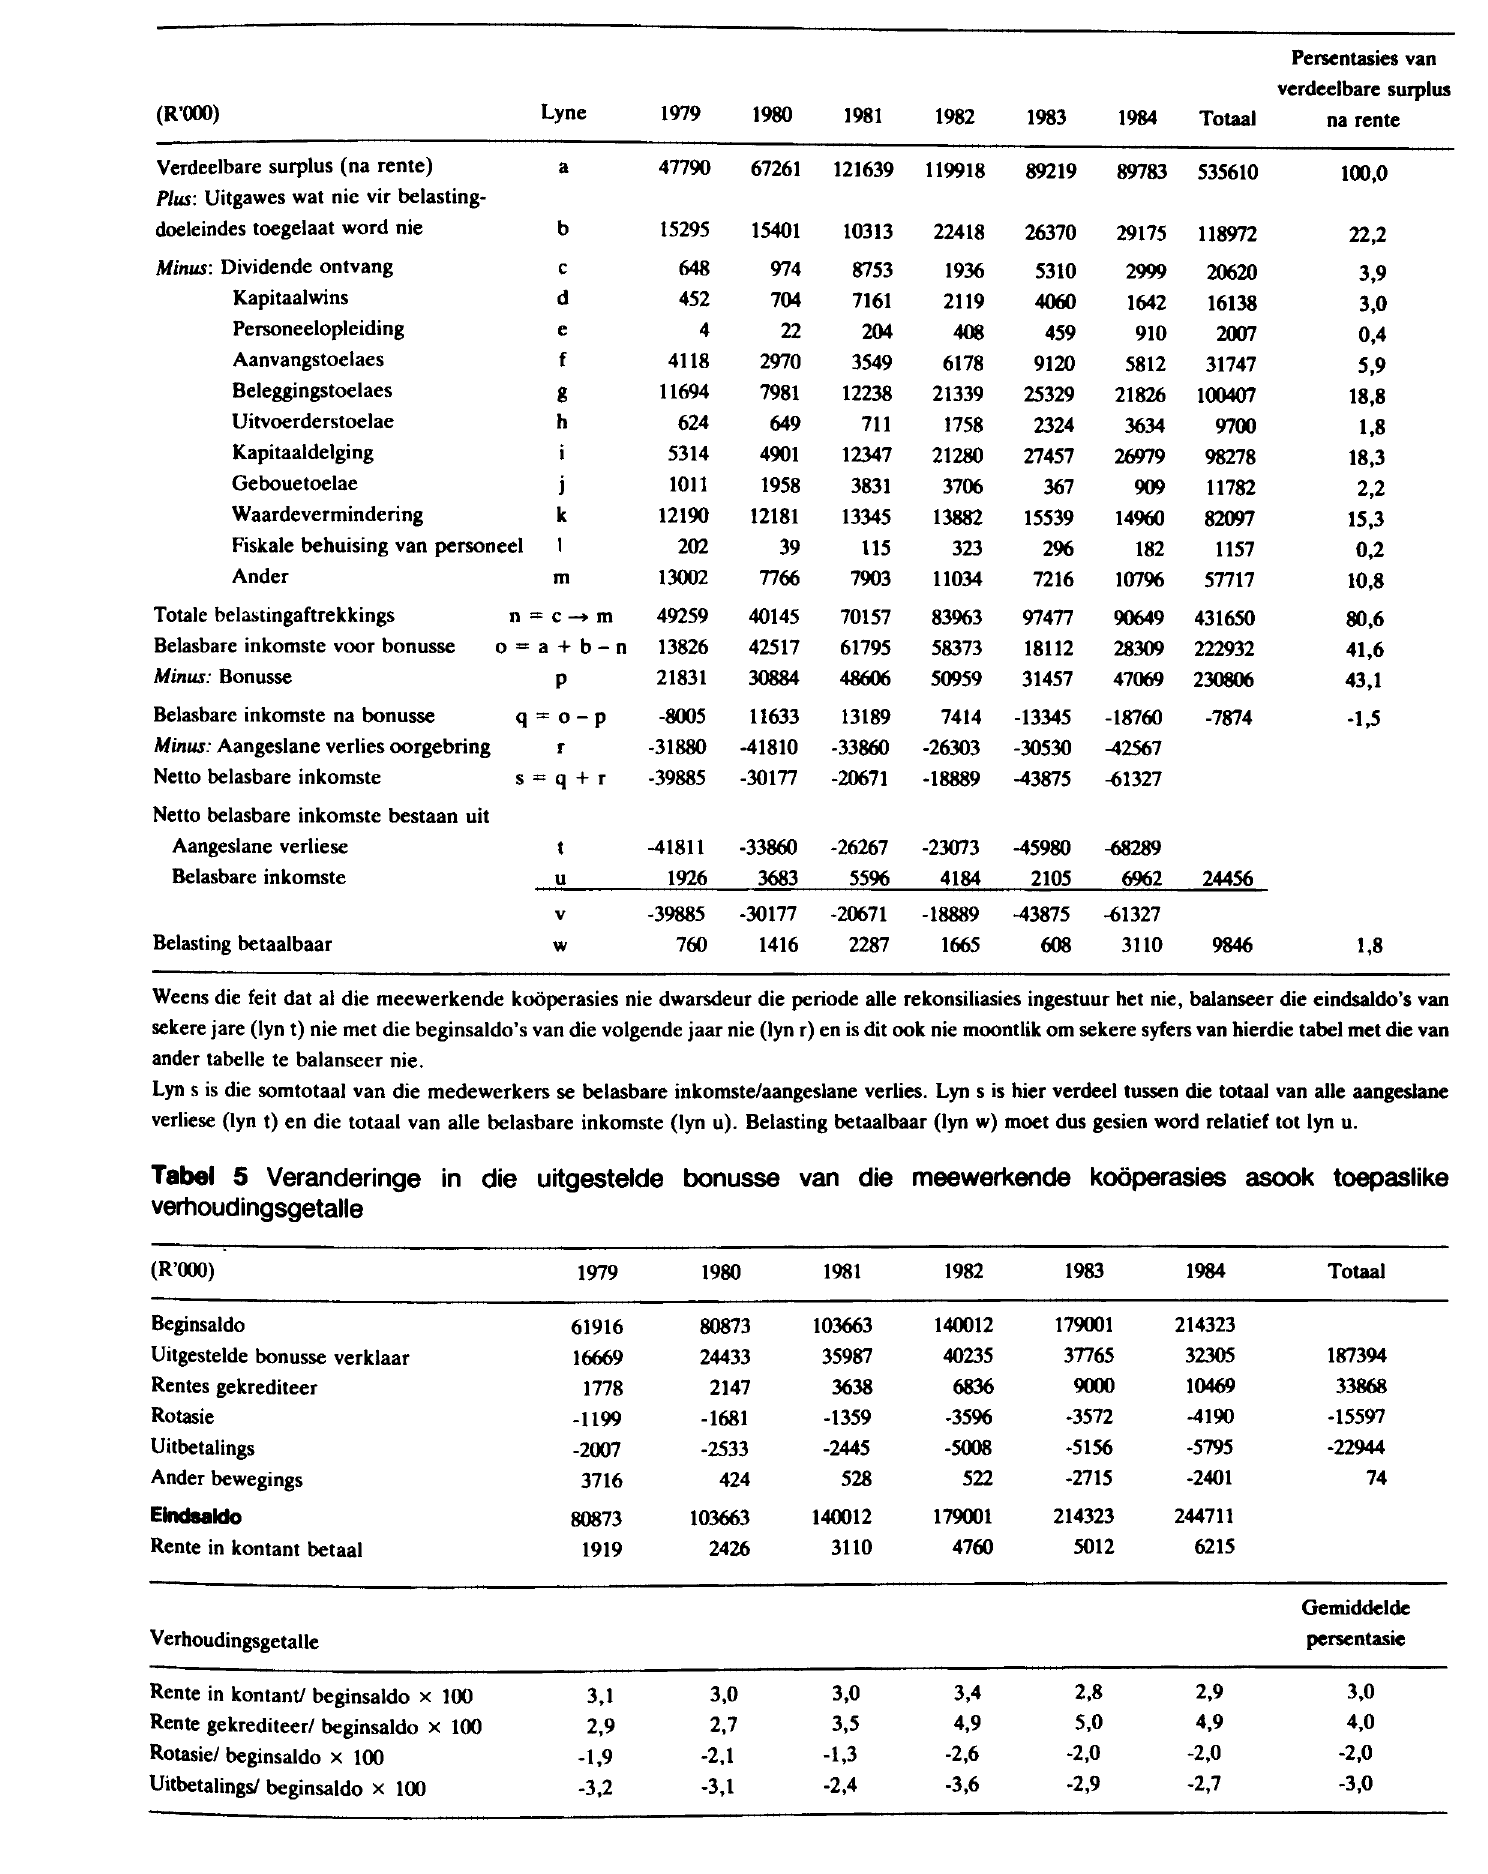
Tabel 4 Rekonsiliasie tussen die verdeelbare surplus na rente en belasbare inkomste/aangeslane ver1ies van die meewerkende